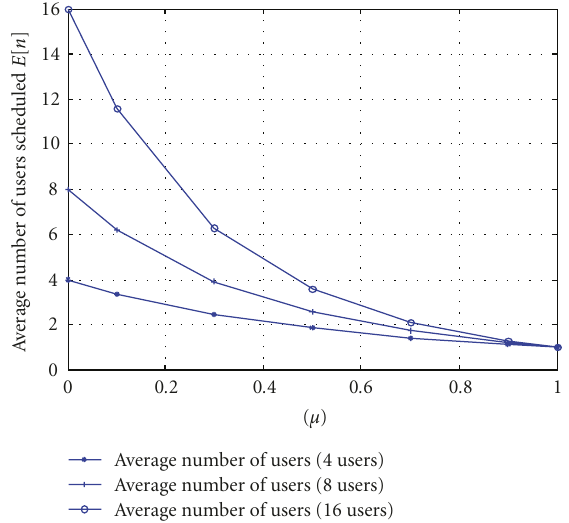
Figure 4: Average number of user scheduled per transmission with respect to threshold level (4, 8, and 16 users per BS scheduler).